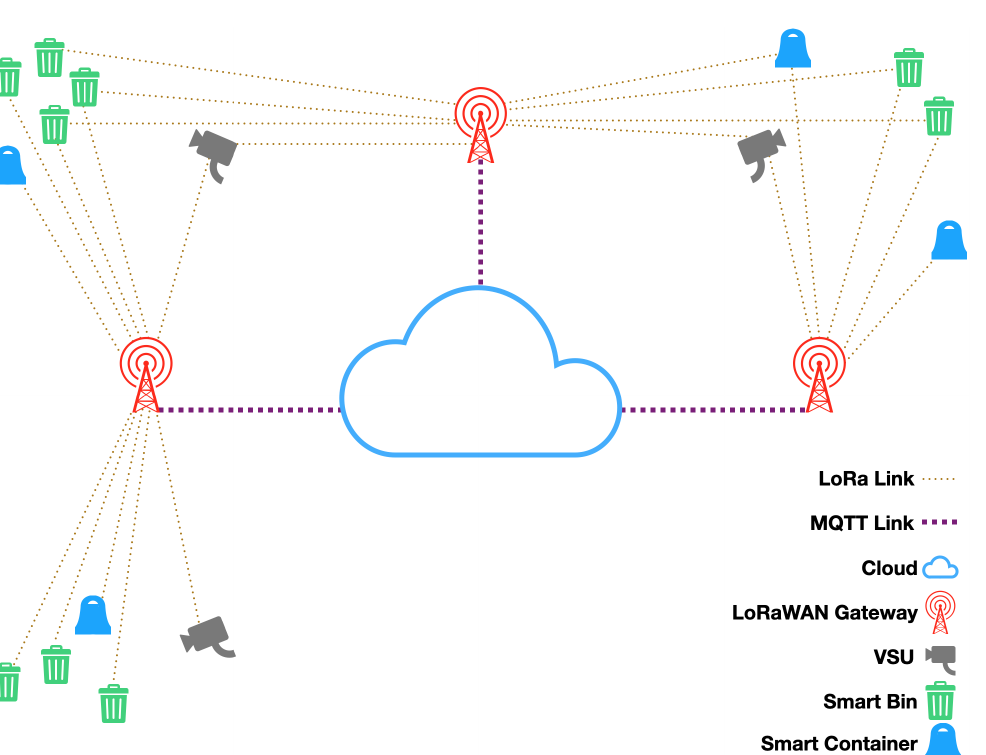
Figure 1. Smart waste management system